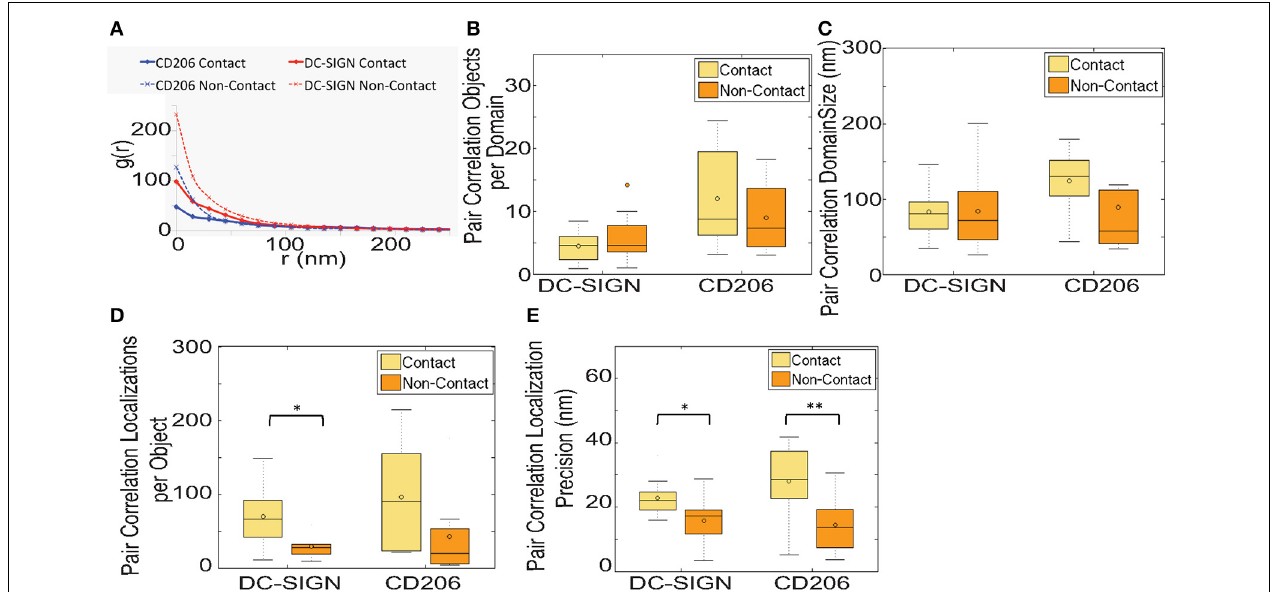
FIGURE 6 | Pair autocorrelation analysis of clustering and local density in fungal contact regions on dendritic cells. (A) Graph of the median value of pair autocorrelation fitting results. (B) Box and whisker plot of the objects per domain from pair autocorrelation analysis. Plot was scaled for visualization of the mean and median values, resulting in some larger outliers for the DC-SIGN Non-Contact ROI to be omitted from the plots (9.1% of the total dataset was omitted). (C) Box and whisker plot of the domain size from